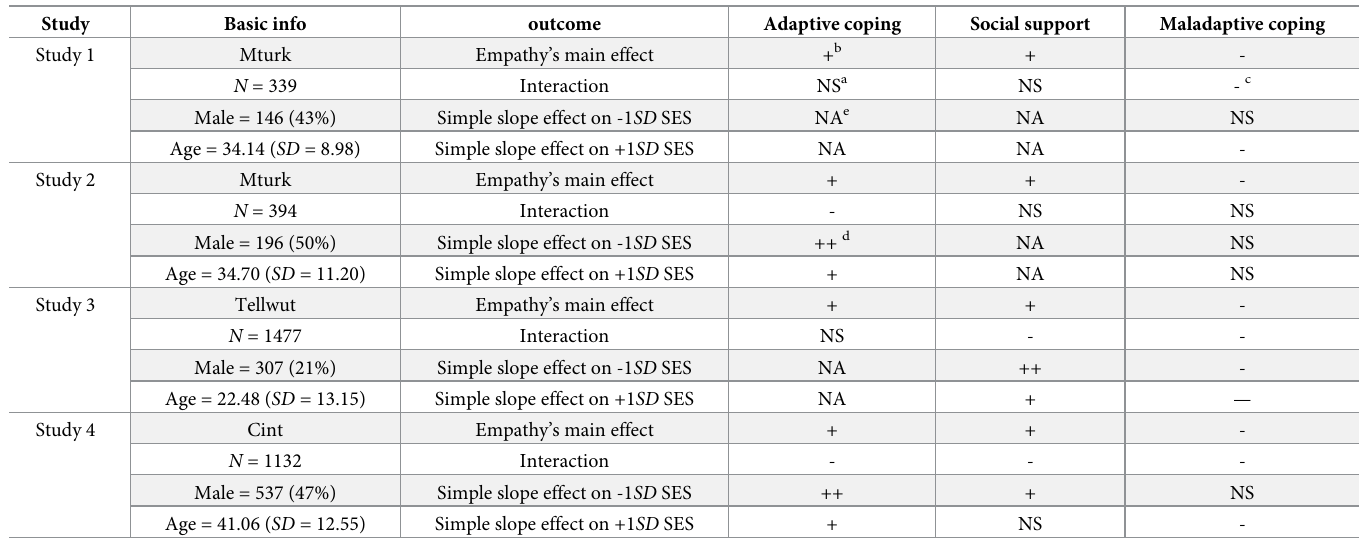
Table 4. Results summary from Studies